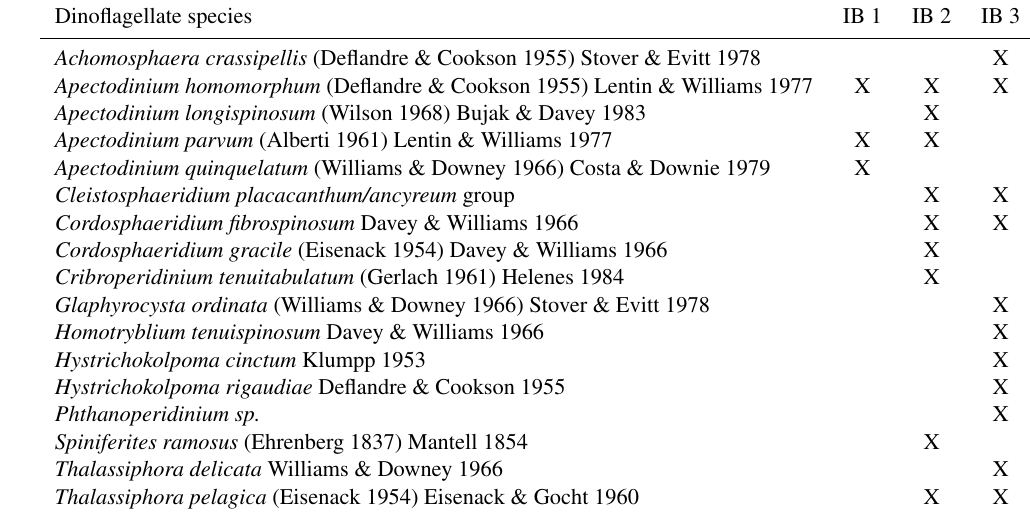
Table 1. List of identified dinoflagellate cyst taxa in Interbed 1, Interbed 2, and the base of Interbed 3 of the Schöningen Formation in the western syncline of the Helmstedt Mining